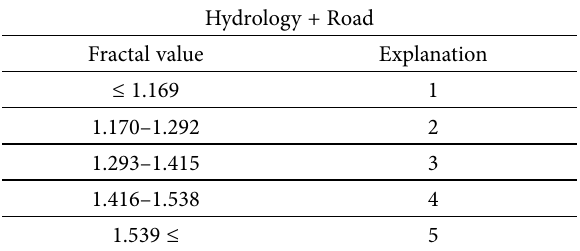
Table 1. Fractal value